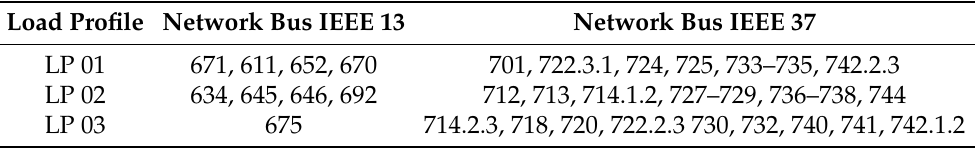
Table 3. The load profile of costumers used in the test